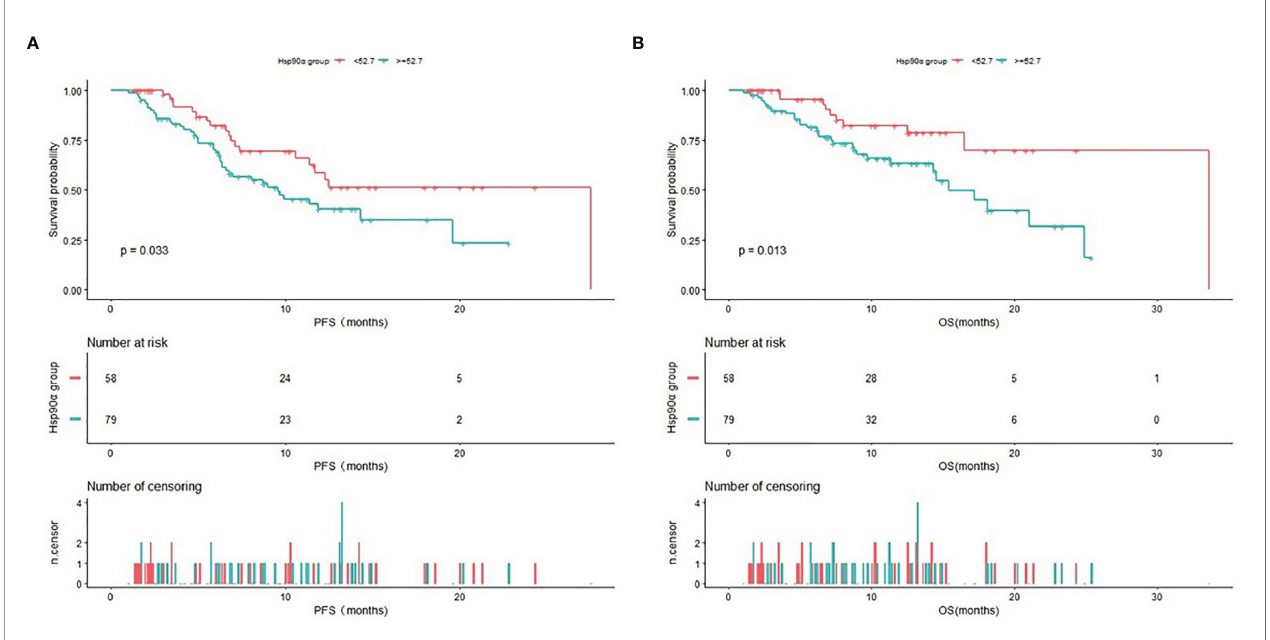
FIGURE 3 | Kaplan – Meier (KM) curves of PFS (A) and OS (B) in advanced lung cancer patients treated with PD1/PD-L1 inhibitors plus chemotherapy strati fi ed by HSP90 a